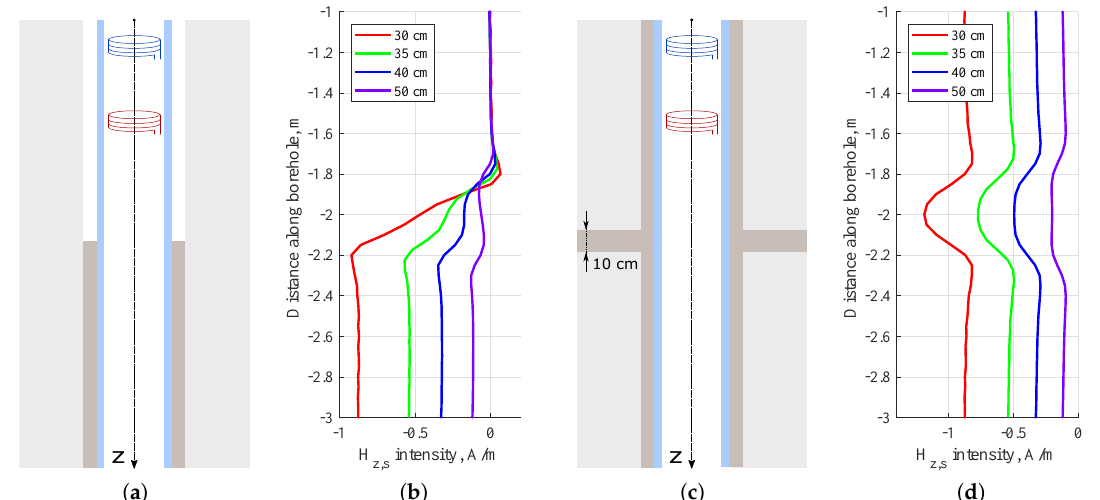
Figure 8. ( a ) The model of an incomplete lift of cement, ( b ) logging signals at the frequency of 1 kHz cross a cement lift, ( c ) the model crack filled with magnetic cement, and ( d ) logging signals at the frequency of 1 kHz cross a crack filled with magnetic cement with different tool lengths considered.